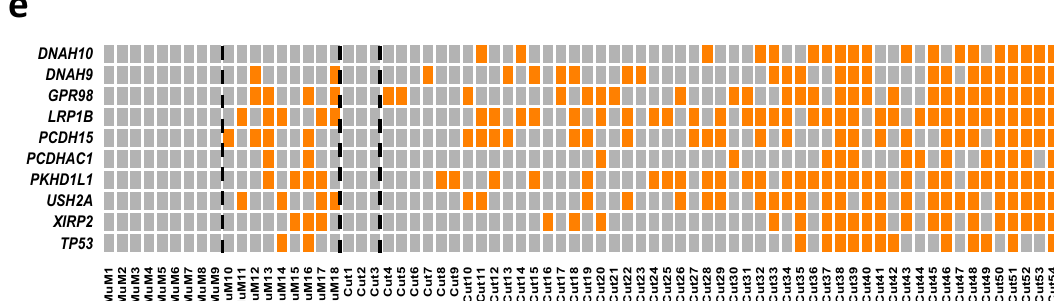
Fig. 2 Structural alterations and gene mutations in mucosal and common cutaneous melanomas. Numbers and types of structural variants in individual melanoma genomes. Indices above indicate mucosal (black, n = 18) and common cutaneous (red, n = 54) melanomas with subdivision into non-SBS7v2 (blue; n = 9, n = 3, respectively) and SBS7v2-dominant (magenta; n = 9, n = 51, respectively) genomes. Columns represent individual tumors. b Relative amounts of chromosomal gains and losses (fraction of genome) in individual genomes. Columns represent individual tumors. c , d Missense (orange) or frameshift (blue) mutations in known melanoma oncogenes ( c ), or TERT promoter regions ( d ) of individual tumors. e Missense mutations (orange) in the indicated genes for individual tumors (columns). Dotted lines denote segregation into non-SBS7v2 and SBS7v2 dominant